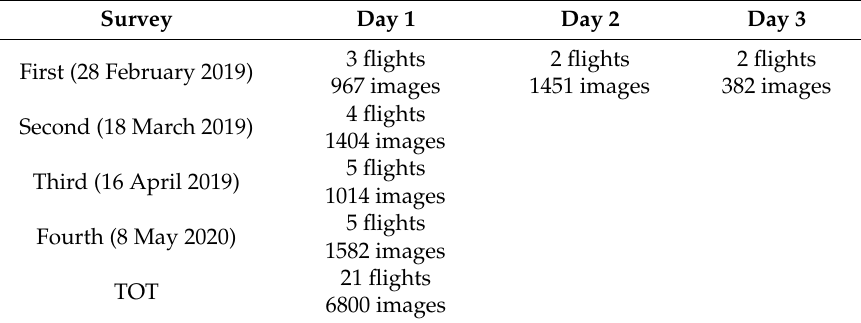
Table 1. Surveys photogrammetric acquisition data.